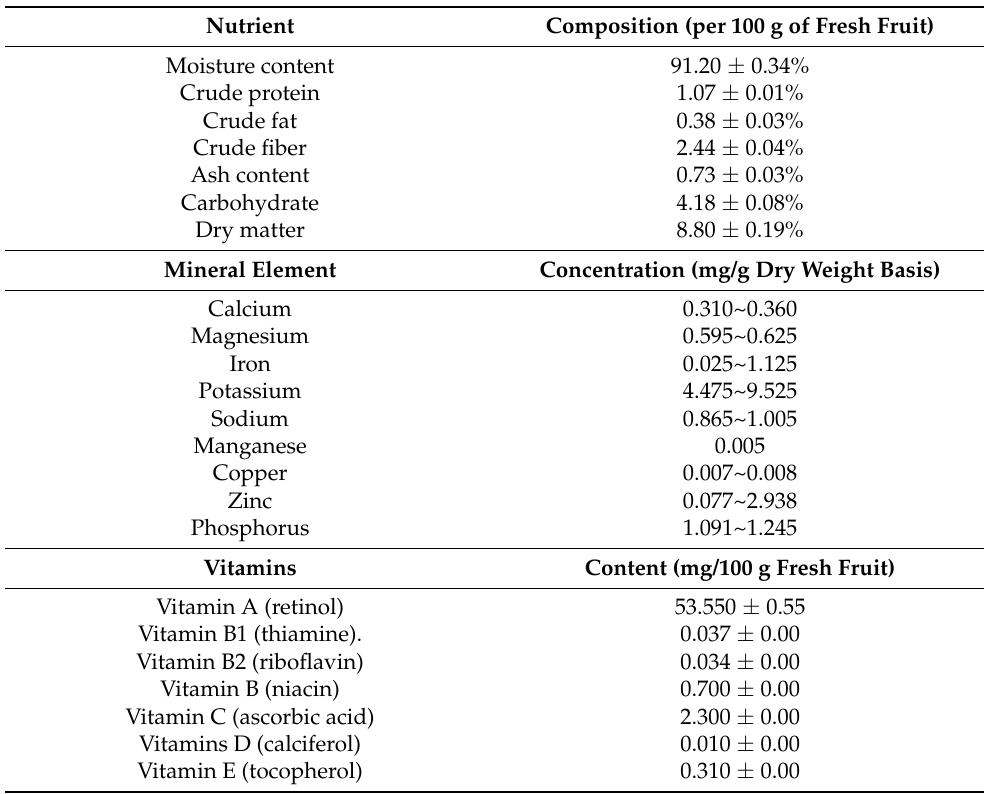
Table 1. Proximate composition of Solanum aethiopicum L.